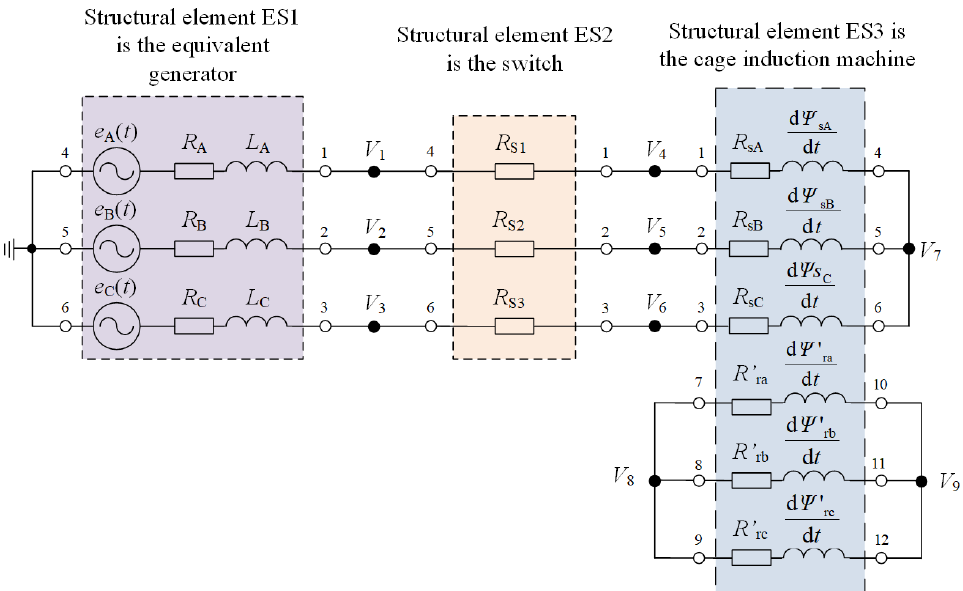
Figure 6. Substitute diagram of the analyzed electromechanical system with division into struc- tural